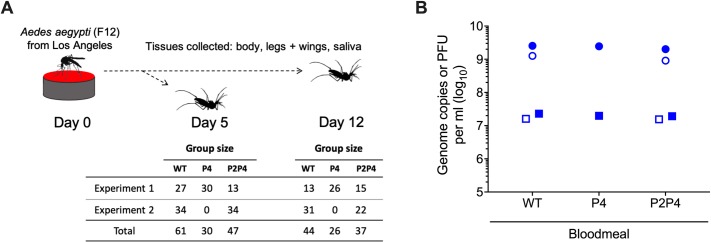
Mosquito infection experiment design and artificial bloodmeal titers for exposure of Los Angeles Ae. aegypti to CHIKV WT and fidelity variant P4 and P2P4.A) Experiment design with group sizes for each treatment group. F12 = 12th generation. B) Back-titration of bloodmeals demonstrating matched CHIKV RNA and infectious virus titers. Closed symbols = replicate experiment 1; open symbols = replicate experiment 2. Circles = genome copies per ml; squares = plaque-forming units (PFU) per ml. Bloodmeal titers for WT presented in panel B are the same as presented in Fig 1A.